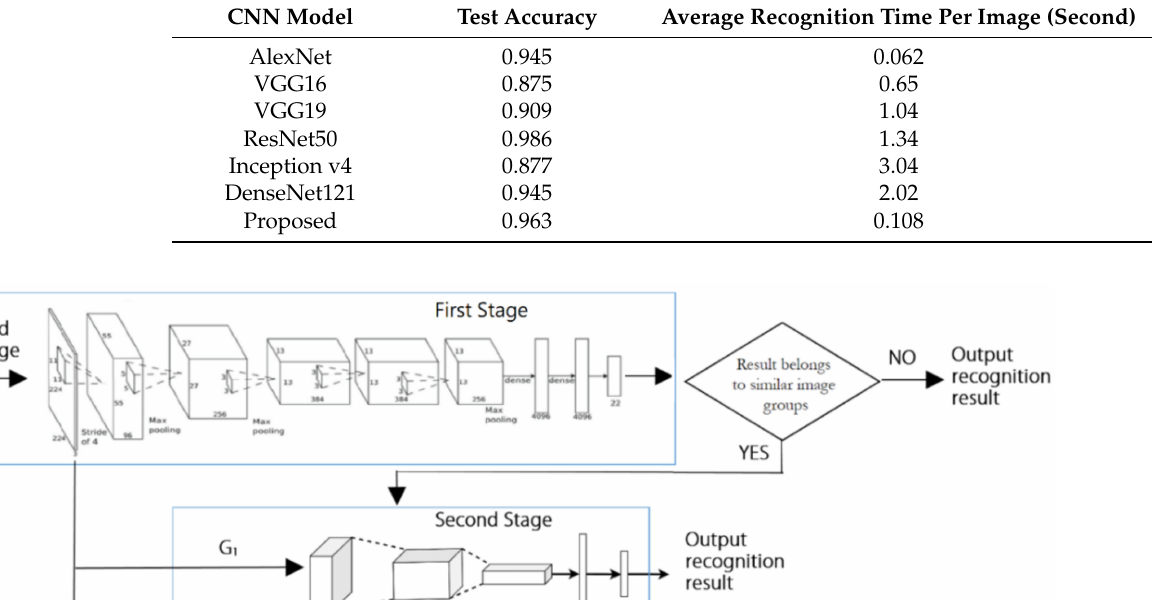
Table 4. Test accuracy with different CNN models and proposed method on the testing dataset.